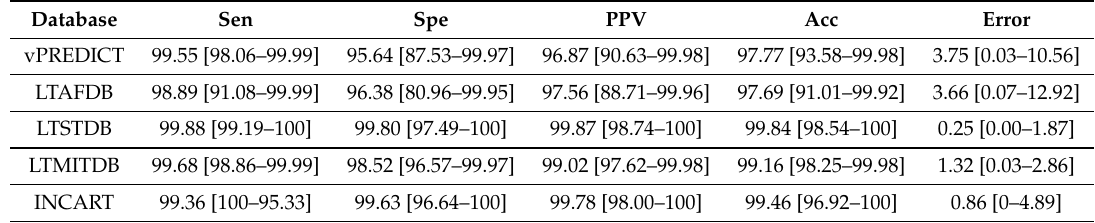
Table 8. Results of the transversal-optimized algorithm using non-LTM